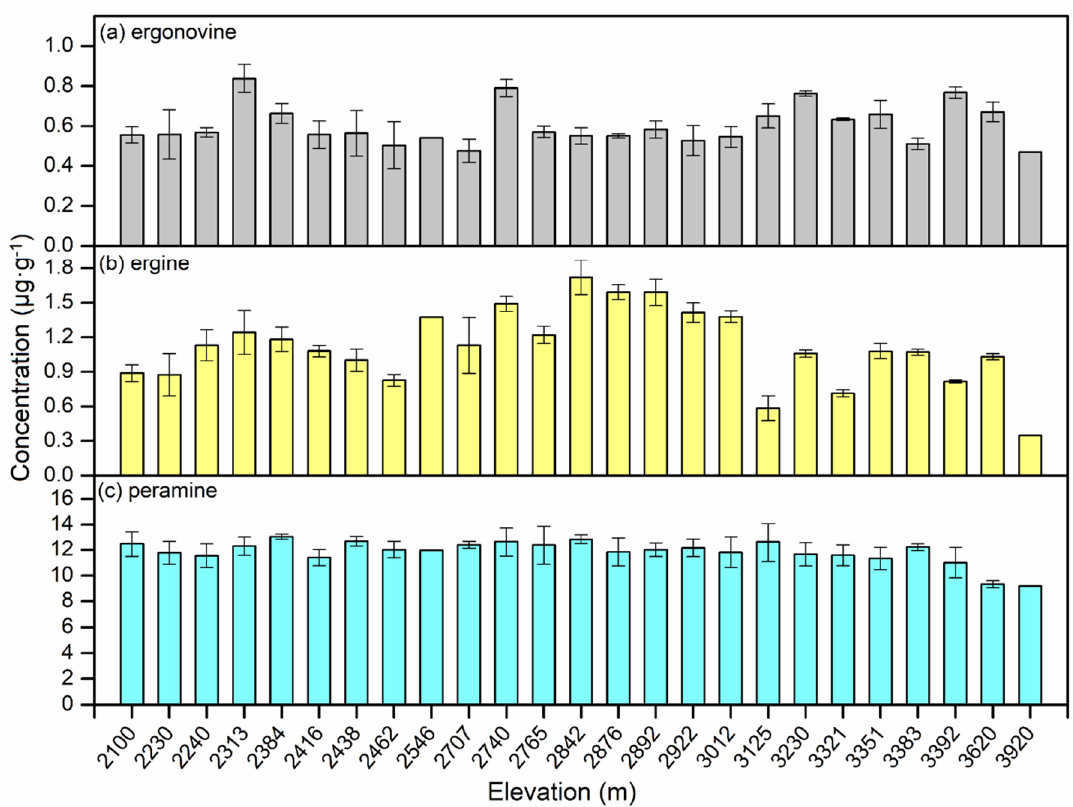
Figure 2. Elevational trends in the Epichloë alkaloid concentrations (average ± SE; the average number of samples per site was 6) of Elymus tangutorum foliage collected from 25 different sites in Qinghai and Gansu provinces: ( a ) ergonovine; ( b ) ergine; ( c ) peramine.